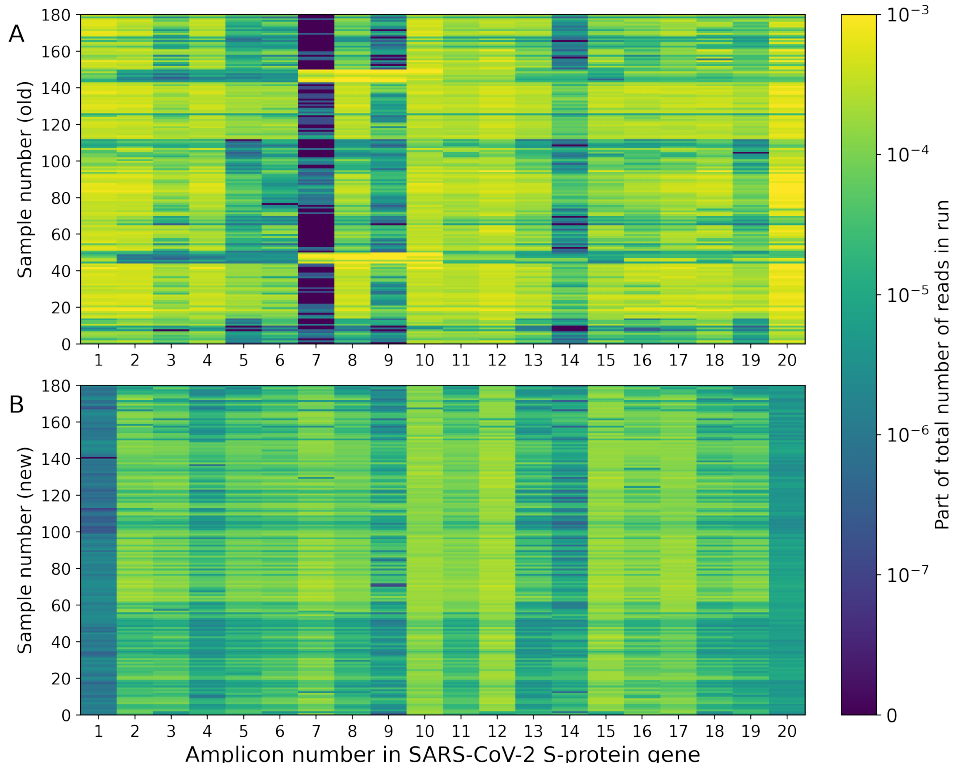
Figure 3. Coverage rates for 20 target regions of SARS-CoV-2 S-protein gene. Two series of 180 sam- ples are presented. The upper color mesh ( A ) shows the coverage drop after the Delta variant became widespread. Several primer pairs became unstable-working, especially pair 7, which demonstrated zero coverage in the majority of cases. After the primer replacement, lower color mesh ( B ) was obtained. More uniform coverage allowed for an increase in the number of samples per sequencing run, and also made it possible to obtain high-quality consensus